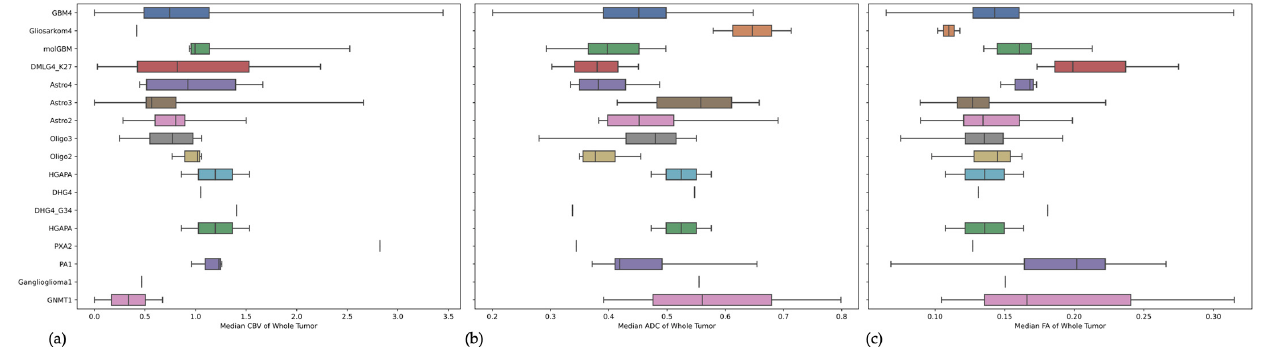
Figure 1. Boxplots illustrating the median values of cerebral blood volume (CBV) ( a ), apparent diffusion coefficient (ADC) from diffusion-weighted imaging ( b ), and fractional anisotropy (FA) from diffusion-tensor imaging ( c ) of the whole tumor volume of all integrated diagnoses as explained in Table 1.